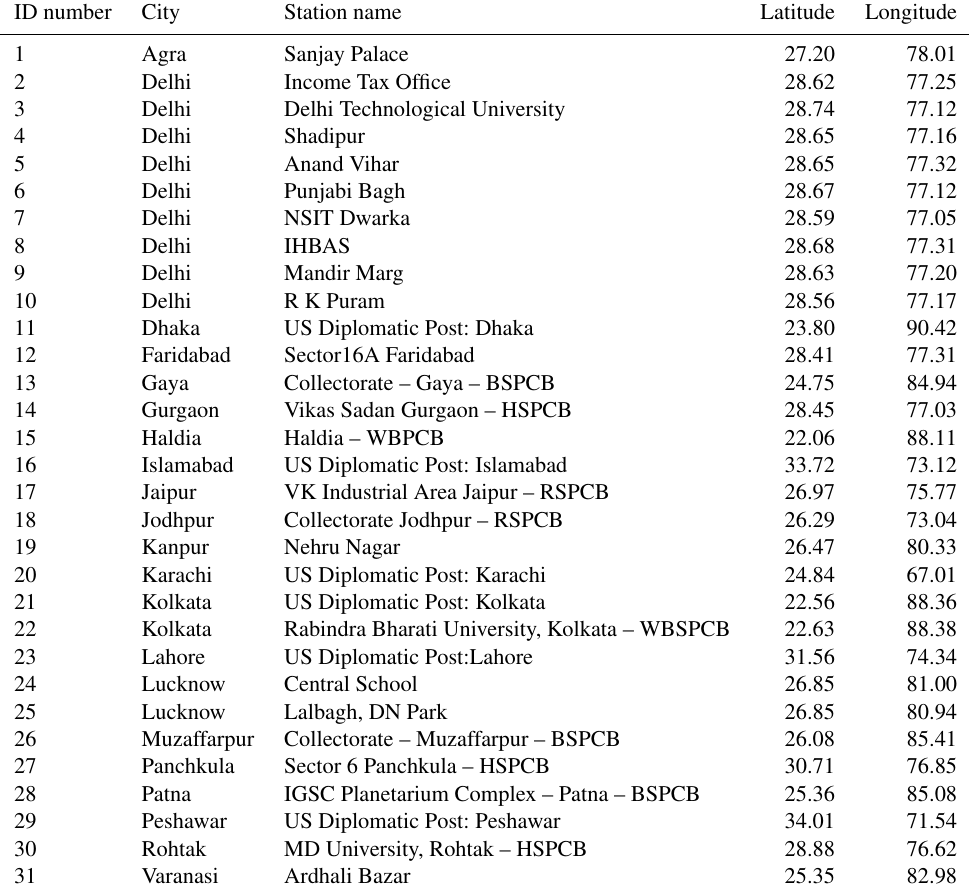
Table B2. List of selected ground-based stations and their measurements used for model evaluation. ID